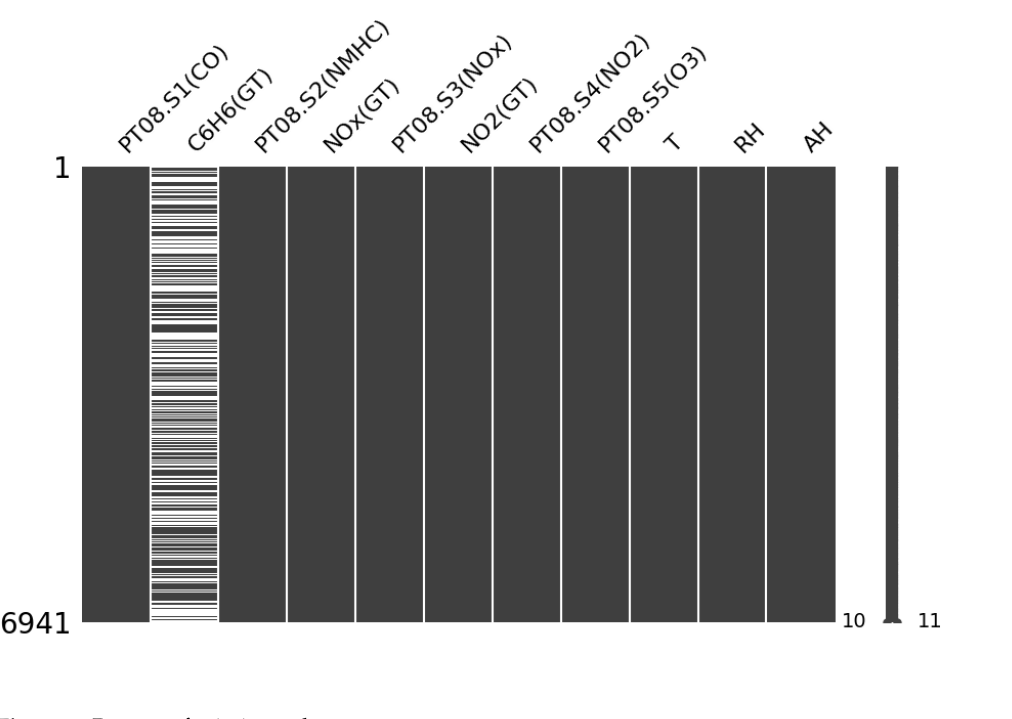
Figure 1. Pattern of missing value occurrence.